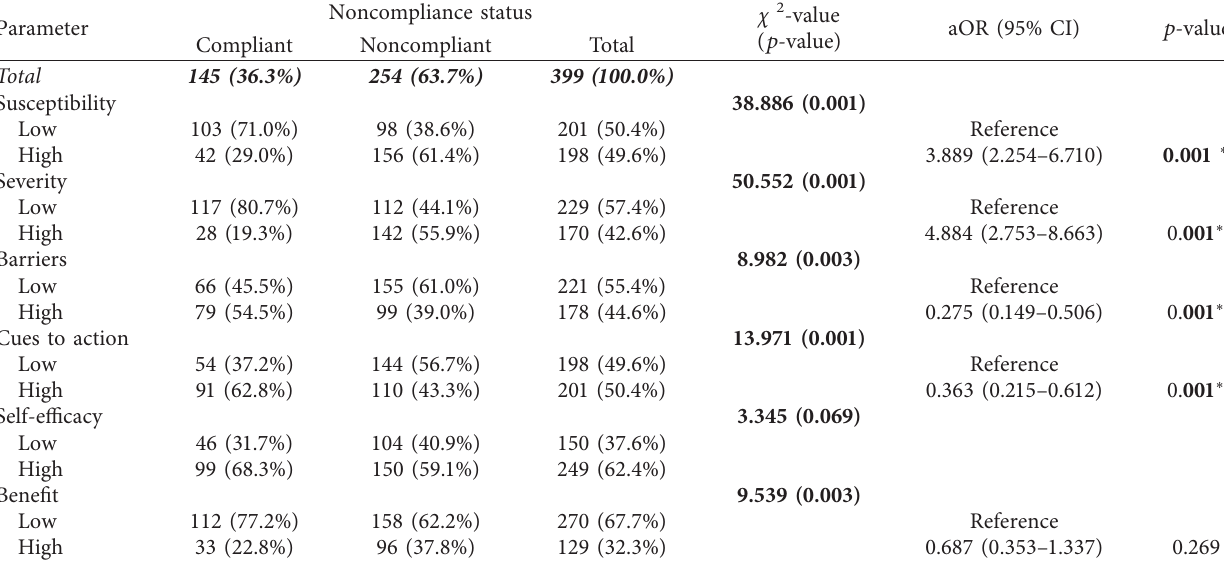
Table 5: Association of constructs of HBM with respondent’s medication nonadherence.